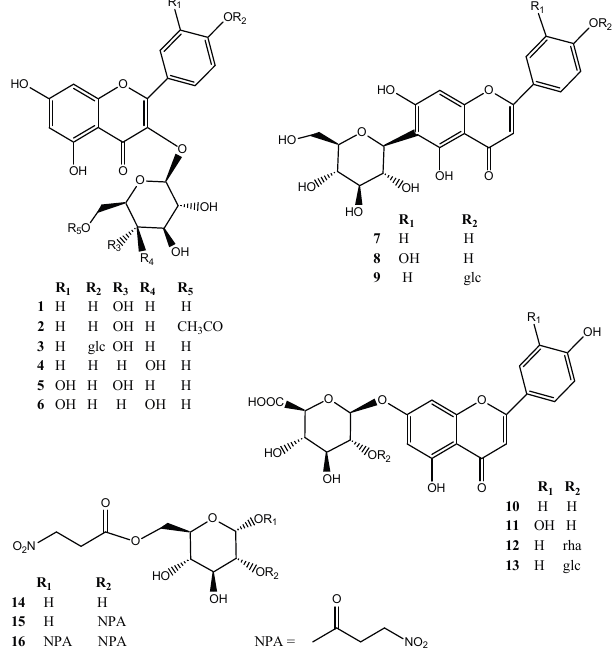
Figure 3. Structures of compounds 1 – 16 isolated from the aerial parts of Securigera